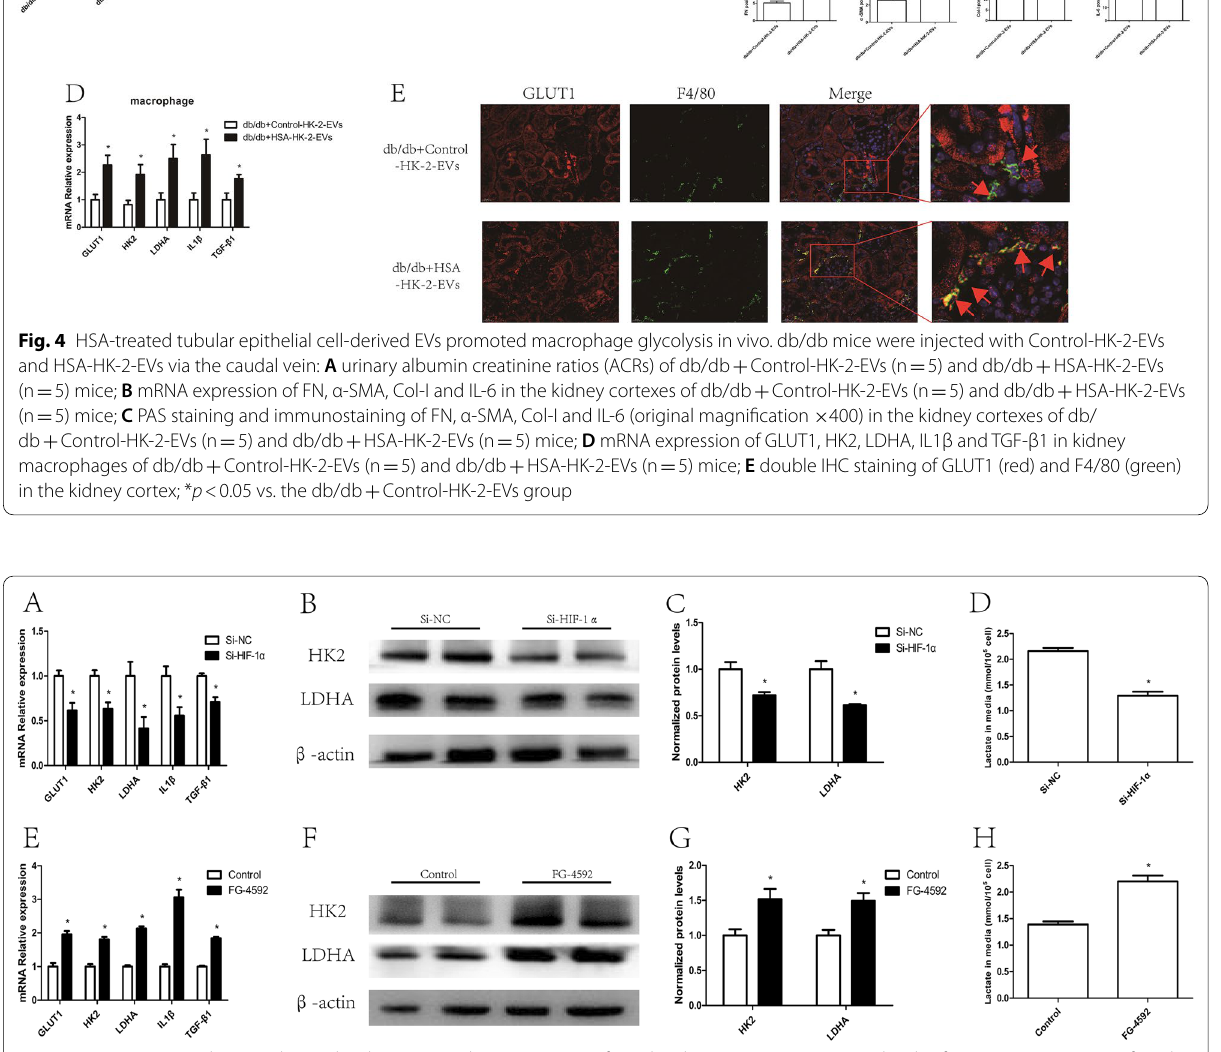
4); D amount of lactate in the macrophage supernatant (n = 3); * p < 0.05 vs. the Control =